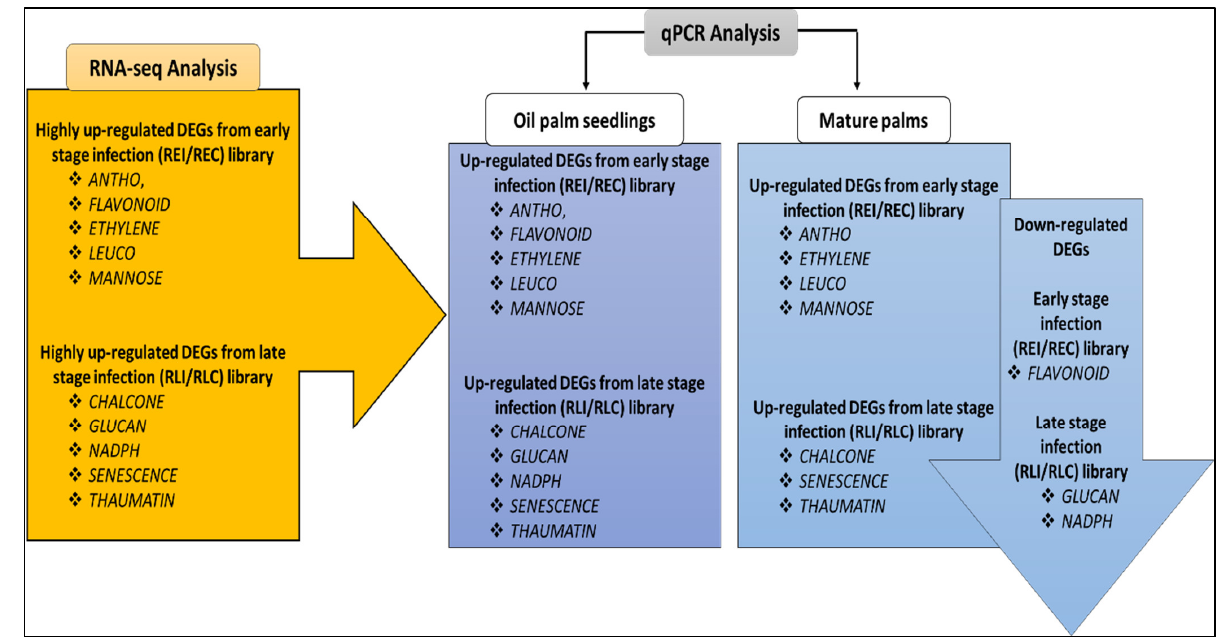
Figure 5. Summary of all 10 DEGs’ expression patterns obtained from RNA-seq transcriptomic libraries and their expression pattern after qPCR verification onto oil palm seedling and mature palms.